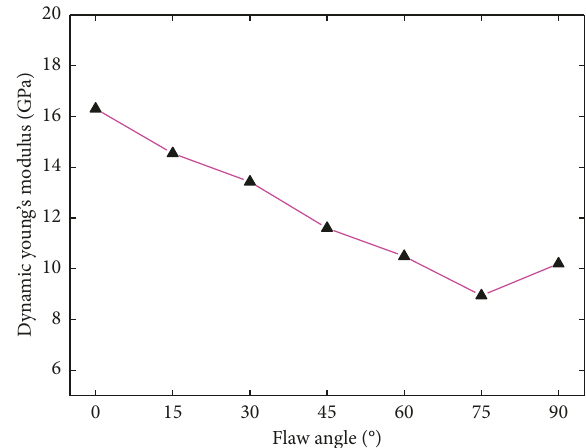
Figure 7: Influence of the flaw angle on the dynamic Young’s modulus of specimens with a constant ligament angle of 0 ° .